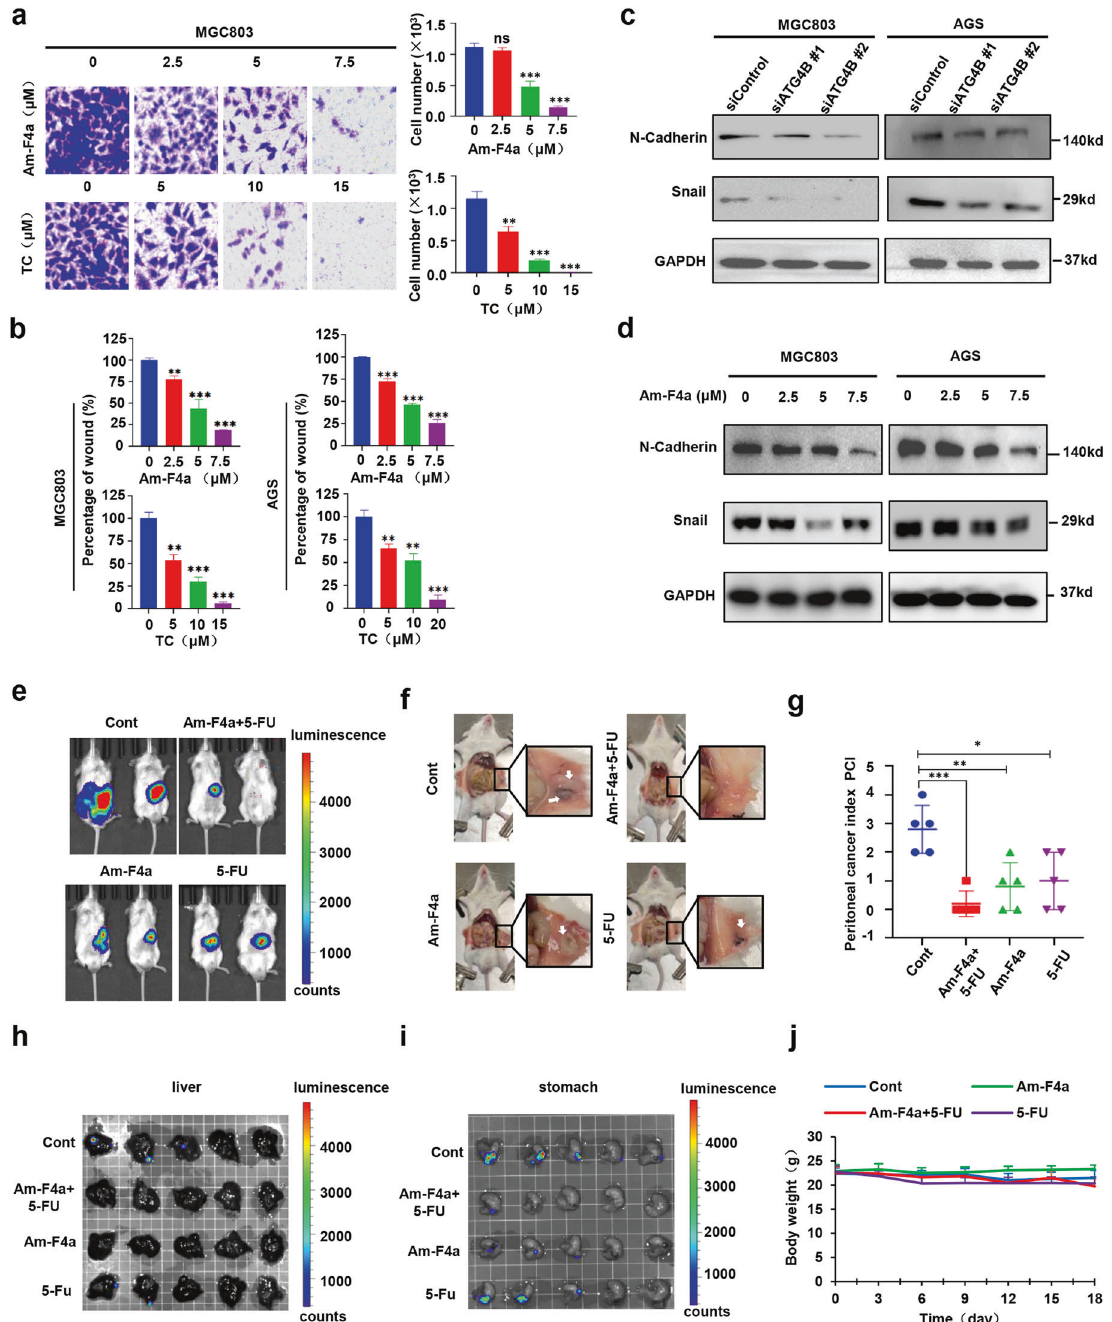
Fig. 6 ATG4B inhibition inhibits GC tumor metastasis. a The invasion ability of MGC803 cells treated with Am-F4a, TC or vehicle at indicated concentration were evaluated by transwell assay. b The migration of GCa cells were determined using would healing assay. c Immunoblotting analysis of indicated proteins in MGC803 and AGS cells transfected with ATG4B or control siRNA and incubated for 48 h. d Immunoblotting analysis of indicated proteins in MGC803 and AGS cells treated with Am-F4a or vehicle for 48 h. e MKN45 cells stable expressing pLenti-Fire fl y Luciferase-EGFP were injected into the stomach wall of NCG mice, and randomly divided into four groups as indicated. Tumor growth in the stomach wall and metastases to the peritoneal cavity or other organs were monitored by bioluminescence at 14th day. f, g Representative image of the peritoneal metastasis (white arrows) of MKN45 cells in mice at the end of study ( f ). The peritoneal nodules were evaluated by peritoneal cancer index (PCI) ( g ). h, i Metastasis on the liver and stomach were monitored by bioluminescence at the end of study. j The body weight of the mice in all groups have no obvious change. All Data shown above was calculated using two-tailed Student ’ s t test, results of animal experiments were shown as mean ± S.E.M, n = 5 mice per group. Cell culture experiments were repeated at least three times and shown as mean ± SD. * p < 0.05, ** p < 0.01, *** p <